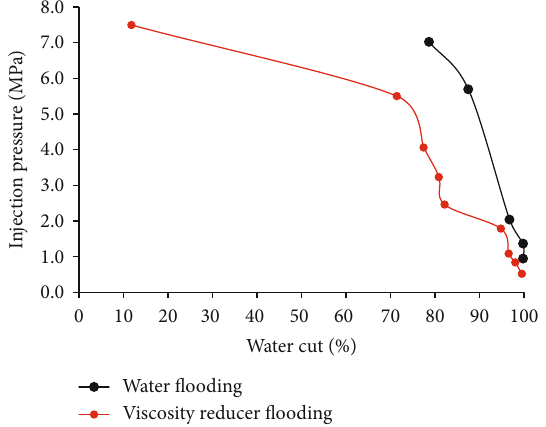
Figure 4: The relationship between injection pressure and water cut for water fl ooding and viscosity reducer fl